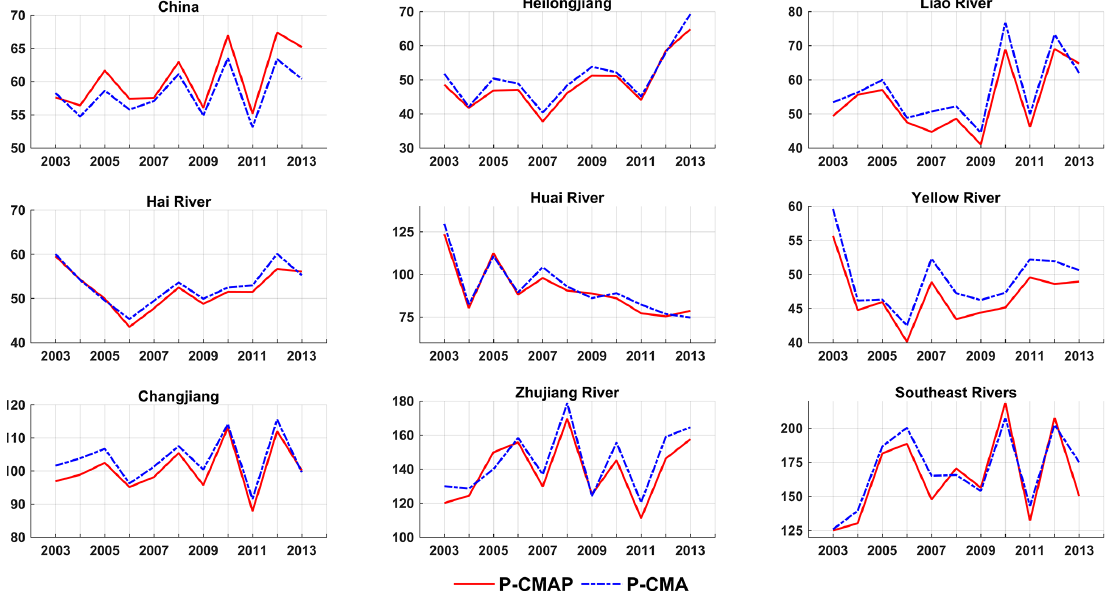
Figure 6. Regionally averaged annual precipitation for China and eight of its basins from 2003 to 2013 (unit: cm). P from CMAP refers to precipitation grid data from GLDAS forcing, and P from CMA refers to precipitation grid data based on station observations provided by China Meteorological